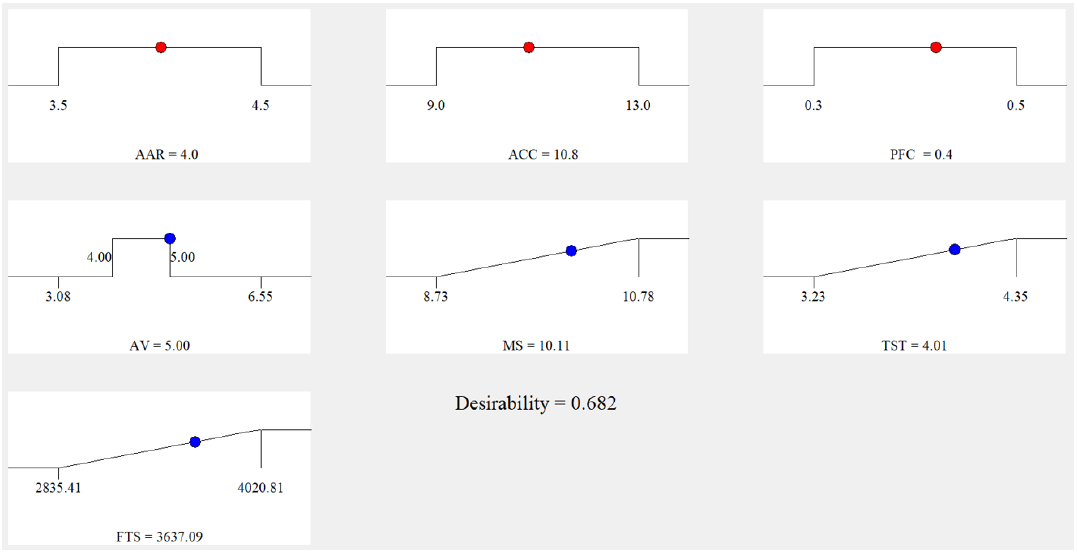
Figure 10. The analysis ramps of CCC.